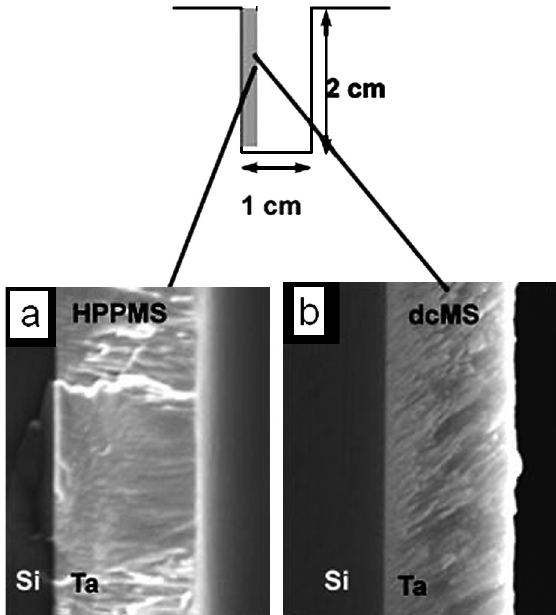
Fig. 3 Cross-sectional scanning electron microscope (SEM) images of Ta films grown by (a) HiPIMS and (b) DCMS on a Si substrate clamped on the side of a trench with an area of 1 cm 2 and a depth of 2 cm. The HiPIMS-deposited film is dense with columns growing perpendicular to the Ta/Si interface. The DCMS- deposited films have a porous microstructure with col- umns inclined toward the flux direction. [Reprinted with permission from Alami et al. (2005). Copyright 2005,